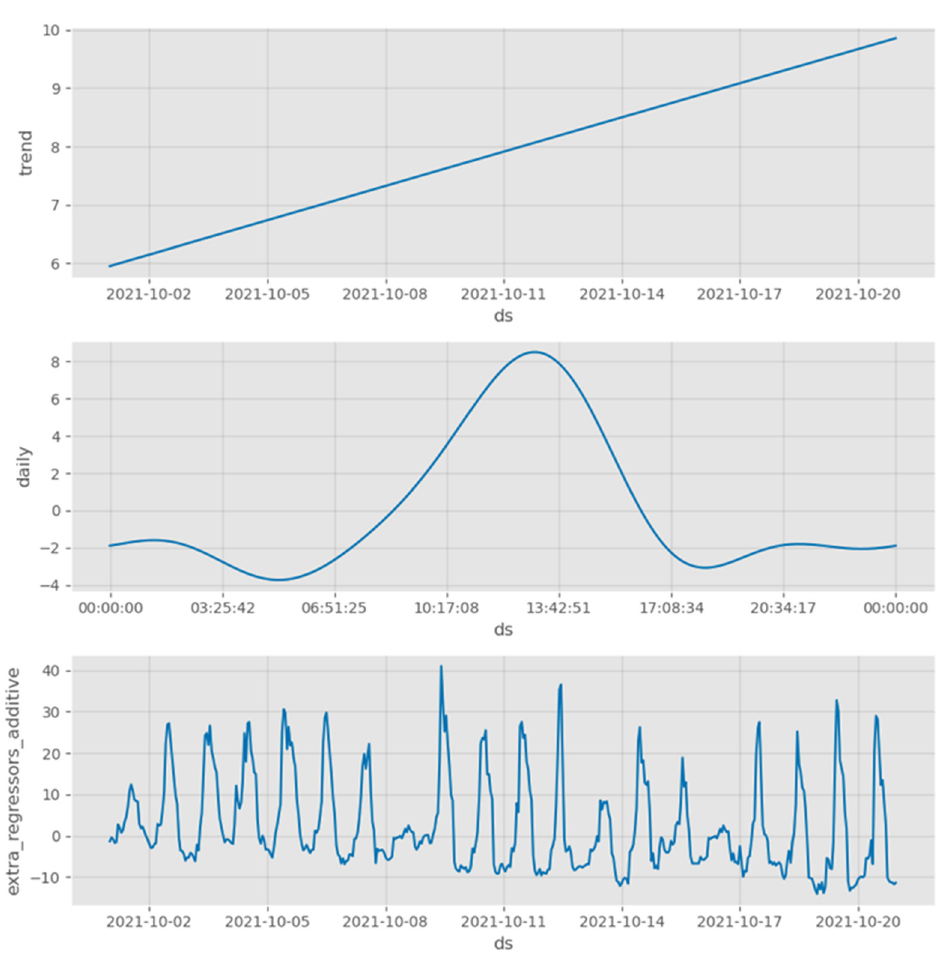
Figure 9. Results of training phase of Facebook Prophet algorithm for BEE_IN variable.